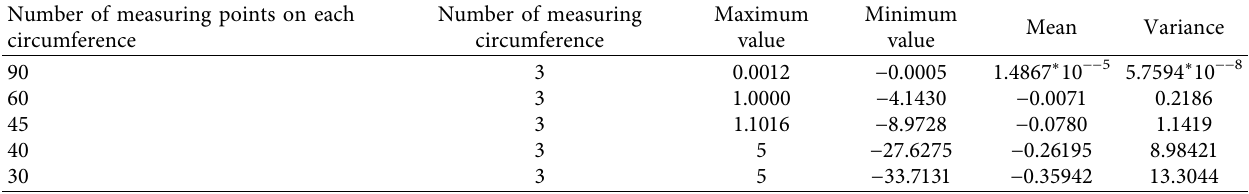
Figure 15: Imaging results with different number of measurement points. (a) The number is 90. (b) The number is 60. (c) The number is 45. (d) The number is 40. (e) The number is 30. Table 1: Error parameters of imaging results under different number of measurement